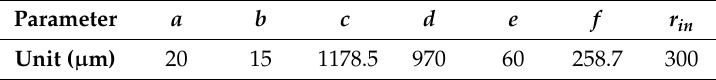
Figure 1. Three-dimensional layout of the proposed bandpass filter (BPF), showing the three laminated layers (bottom to top: Bond layer, Text layer, Leads layer). Table 1. Dimensional parameters of the Bond layer.